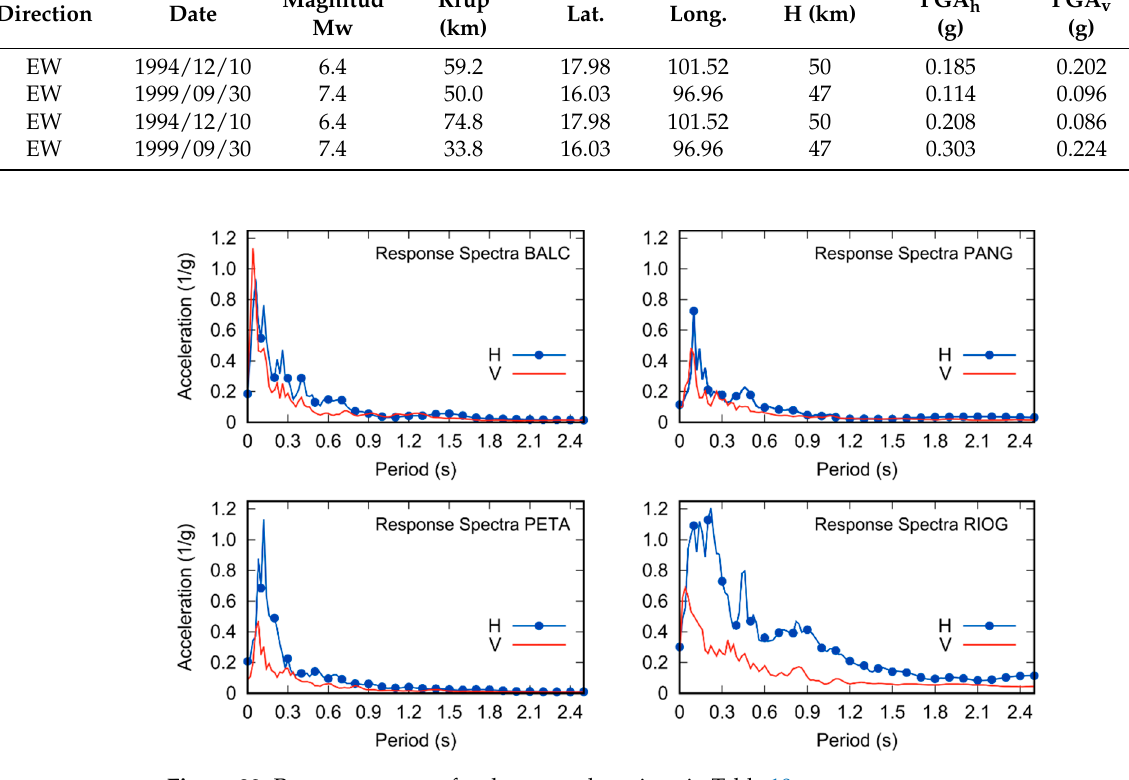
Figure 20. Response spectra for the ground motions in Table 10.